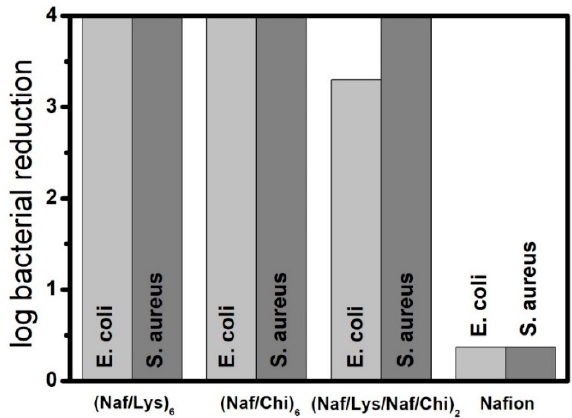
Figure 4. Reduction (in log scale) of the population of E. coli and S. aureus cultures exposed to (Naf/Lys) 6 , (Naf/Chi) 6 , (Naf/Lys/Naf/Chi) 2 , and Nafion coated QCM-D crystals. (For each type of coating five crystals were tested and the average values are shown in this figure).